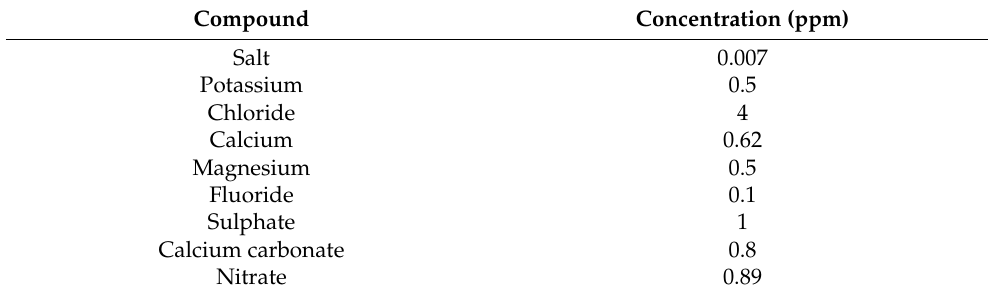
Table 1. Contents of prepared bottled water (ppm) (pH = 5–6) used to prepare the 1% PGS solution.